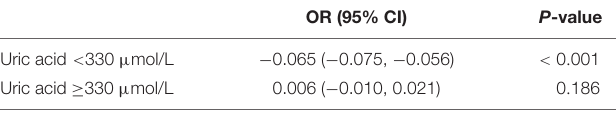
TABLE 5 | The threshold effect of serum uric acid levels on score of BFMDRS